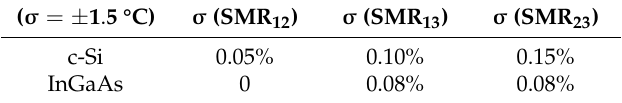
Table 1. Variations associated with spectroradiometer temperature errors for the case input σ = ±1.5 ° C .